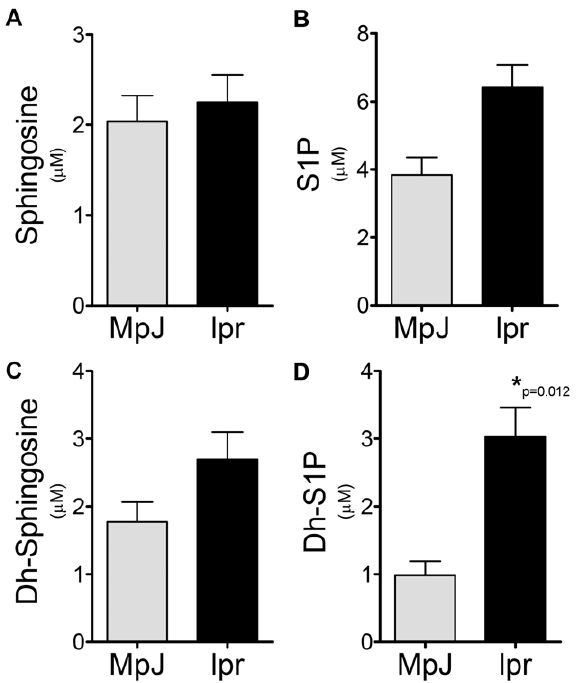
Figure 1. Lupus mice have elevated Dh-S1P levels in circula- tion. Serum was collected from MRL/lpr and MRL/MpJ mice and analyzed for sphingolipid content by the Lipidomics Shared Resource at MUSC, A ) sphingosine, B ) S1P, C ) Dh-sphingosine and D ) Dh-S1P. Data represent mean 6 SEM, n=6.